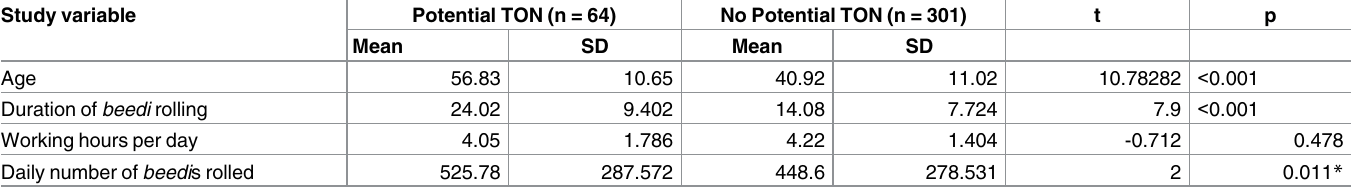
Table 3. Comparison of mean age, duration of beedi rolling, working hours per day and daily number of beedis rolled between those with and with- out potential toxic optic neuropathy (TON) among beedi rollers in selectedrural areasof Dakshina Kannada district, Karnataka, India, April-Sept 2016 (N =